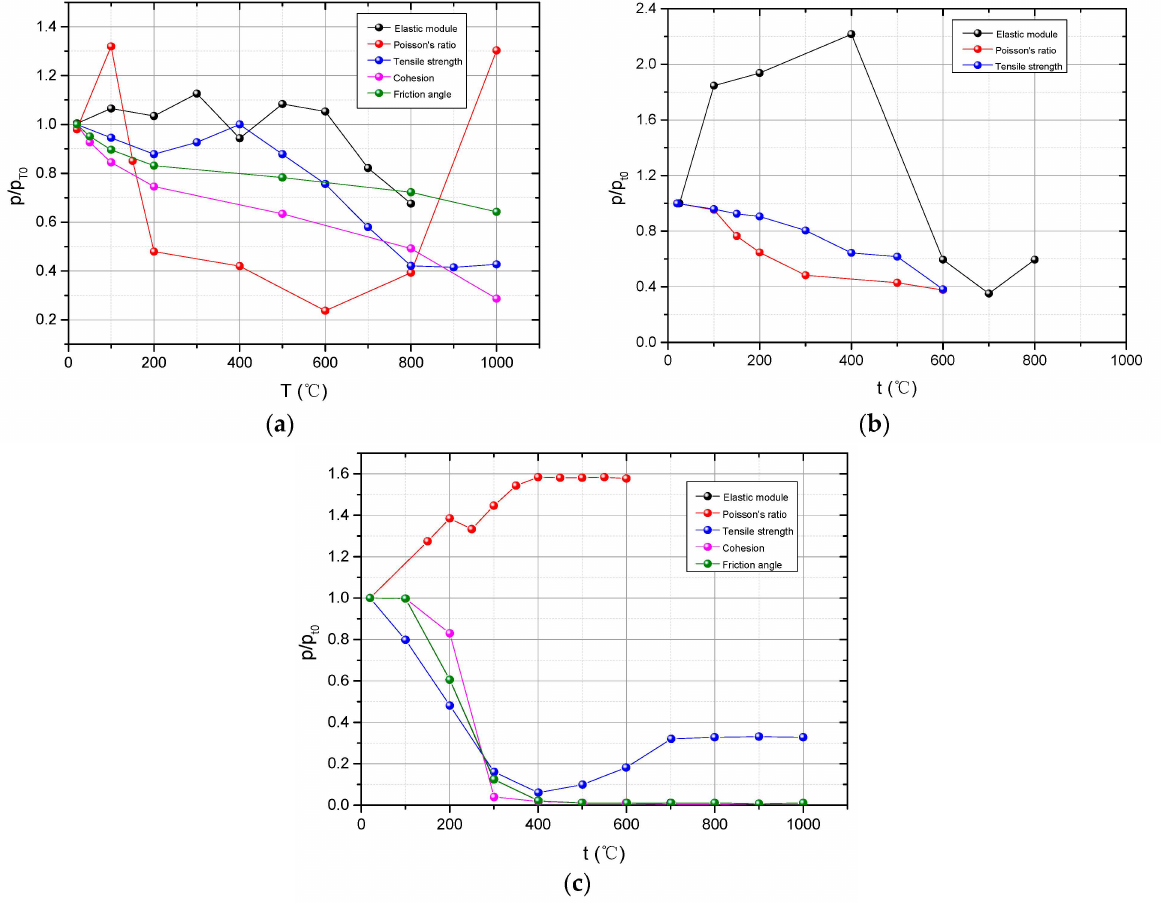
Figure 2. Variation of mechanical properties of coal and rock at high temperature. ( a ) mudstone. ( b ) sandstone. ( c ) coal